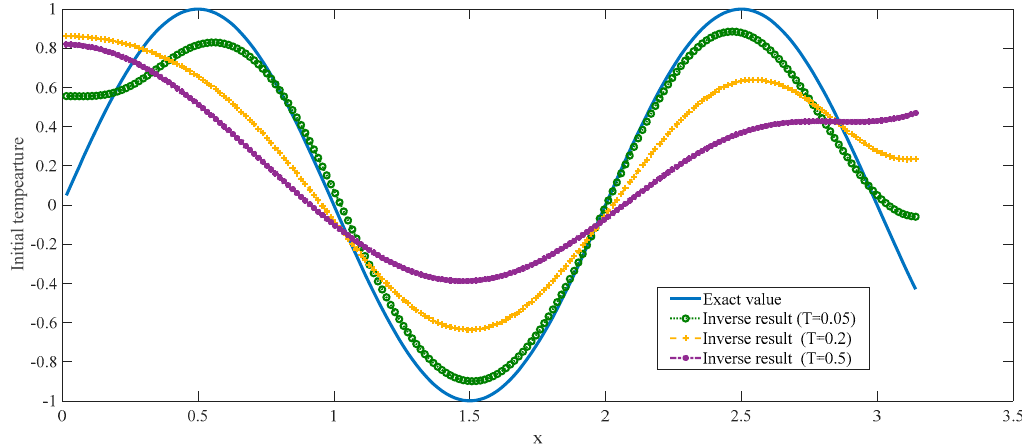
Figure 2. Recovery of u ( x ,0 ) from exact u ( x , T ) with di ff erent T .